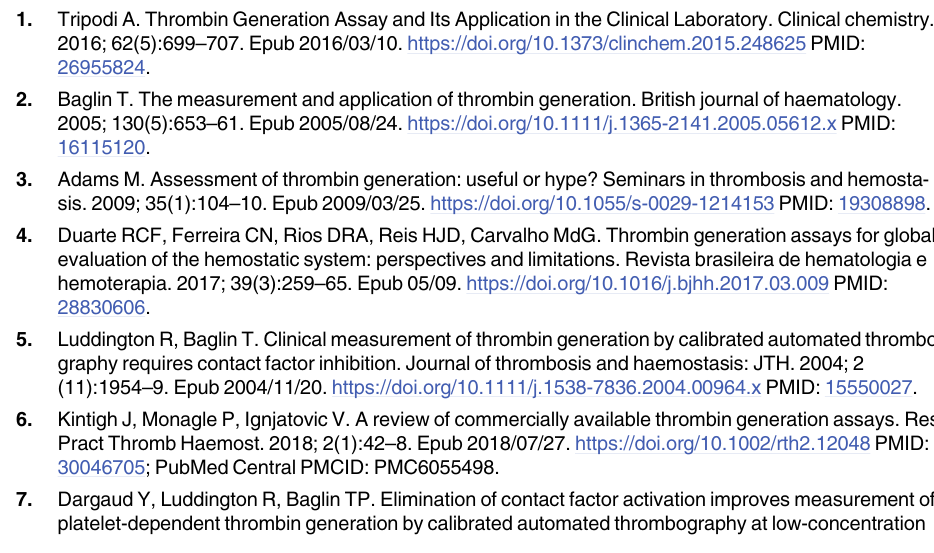
S1 Table. Mean change in thrombin generation parameter with 1 SD increase in coagula- tion factor for CAT. S2 Table. Mean change in thrombin generation parameter with 1 SD increase in coagula- tion factor for